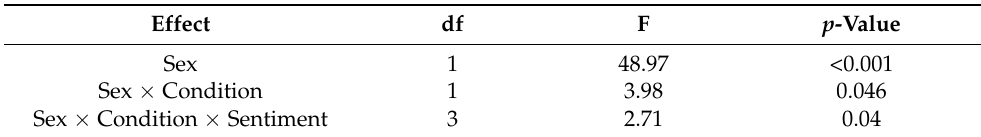
Figure 9. Physiological Arousal Change Elicited by Touches with Negative or Positive Utterances in Males. Table 9. Significant Main Effects on Change in Physiological Arousal. Only affective touches were considered.